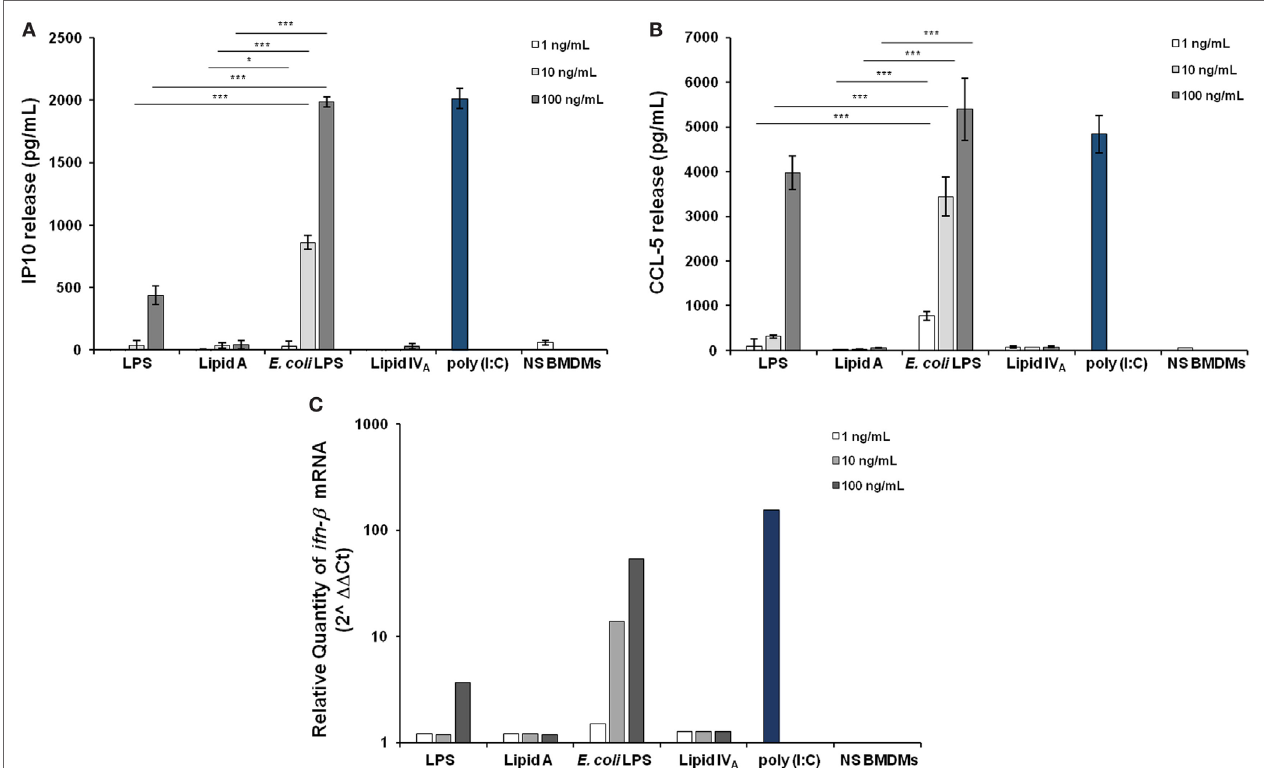
FigUre 3 | Assessment of the involvement of Trif pathway upon stimulation of BMDMs with Bradyrhizobium LPS/lipid A. Inducible protein 10 (a) and CCL-5 production (B) in BMDMs stimulated with Bradyrhizobium LPS/lipid A at the concentration of 1, 10, and 100 ng/mL for 6 h. Commercial hexa-acylated Escherichia coli LPS or synthetic lipid IV A were used at the same concentrations. The TLR3 agonist poly (I:C) (5 µg/mL) was used as a positive control of Trif pathway activation. Data are expressed as mean ± SD of three independent experiments in triplicate. * p < 0.05, ** p < 0.01, and *** p < 0.001, after Student’s t -test. (c) q PCR of ifn- β mRNA following 3 h of stimulation of BMDMs with LPS/lipid A at the same concentrations, as above. Results are normalized to the internal TBP gene control and are presented on a logarithmic scale as the ratio of gene expression between stimulated and unstimulated